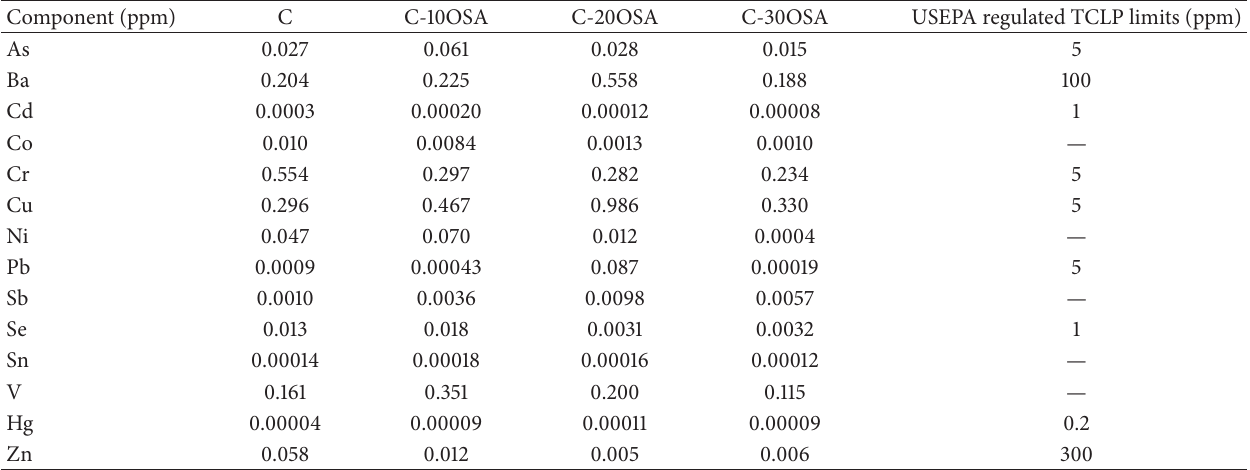
Table 4: USEPA TCLP test results (ppm) and the maximum concentration of contaminants for toxicity characteristics of fired clay and fired clay-OSA